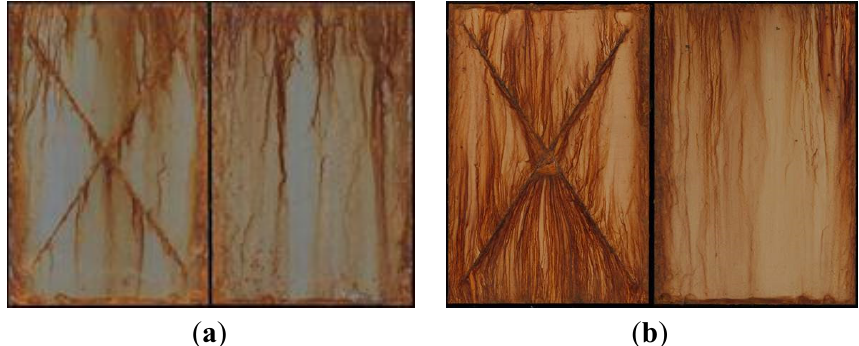
Figure 4. BAM-PPV coated on ( a ) as-received and ( b ) grit-blasted 4130 steel coupons